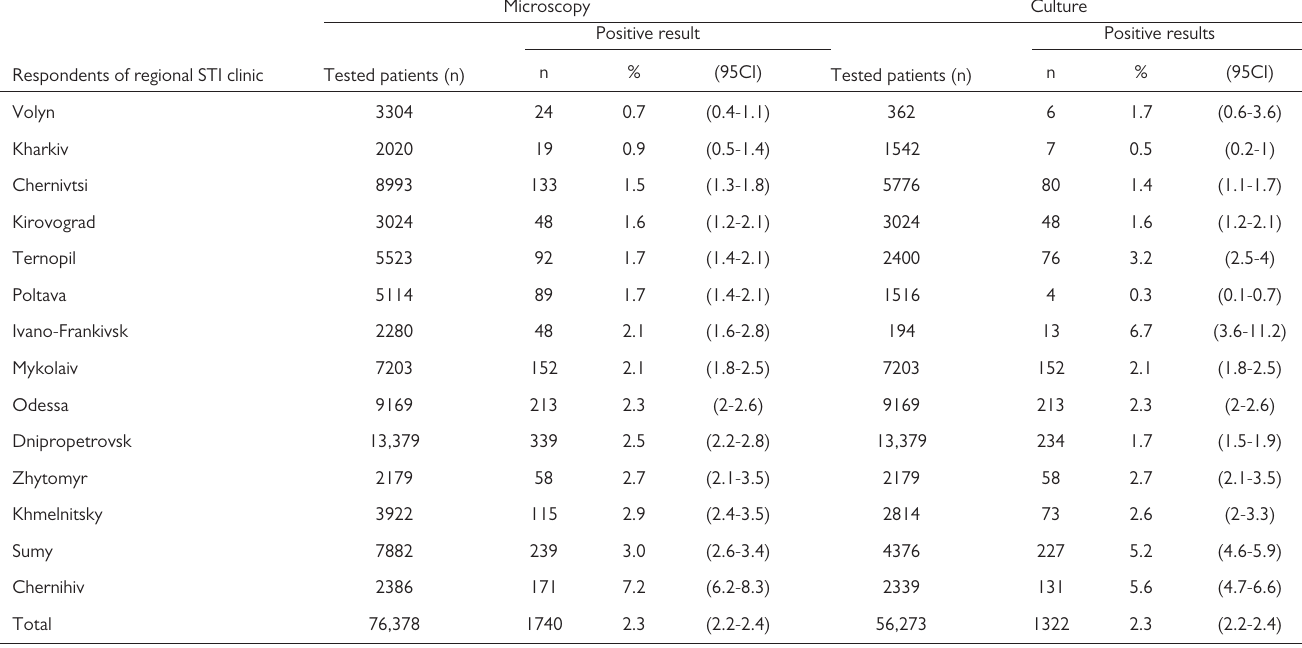
Table2. Positive Results of Neisseria Gonorrhoeae Testing by Microscopy and Culture in Regional STI Clinics, Ukraine